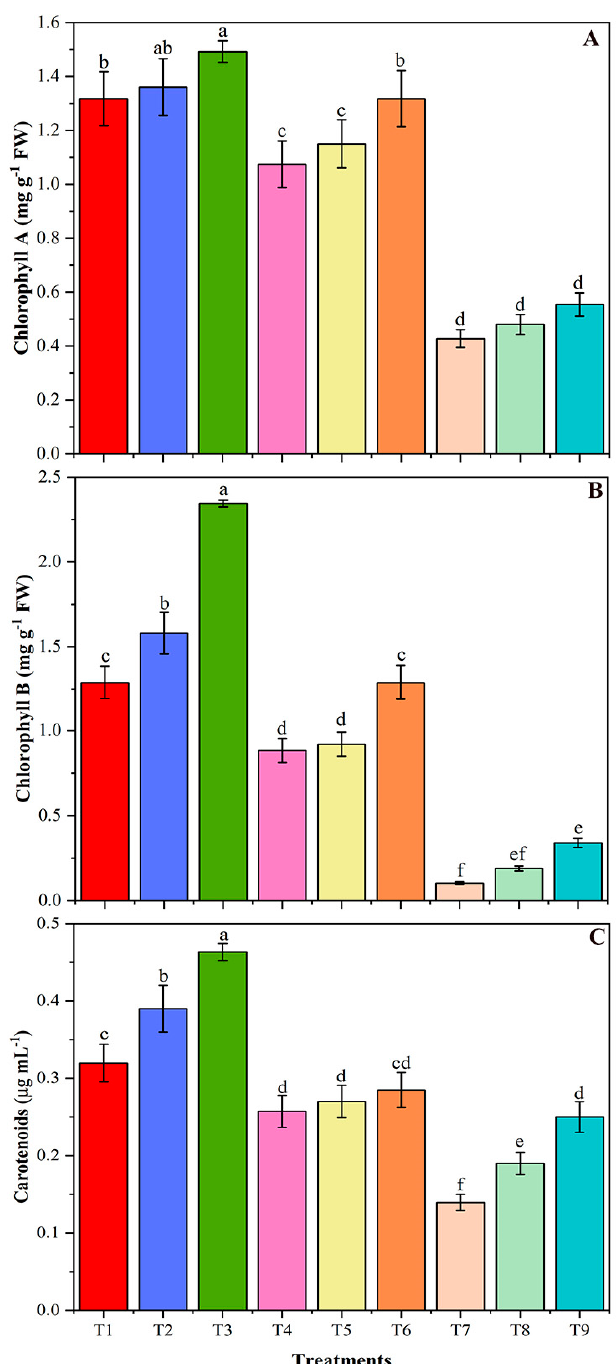
Figure 4. The chlorophyll A ( A ), chlorophyll B ( B ), and carotenoids ( C ) contents of un-amended and amended soybean plants with chitosan modified and as-is biochar under saline conditions. Data are shown as the mean ± standard deviation (n = 3). Di ff erent letters above the chart columns indicate significant di ff erences among treatments ( p ≤